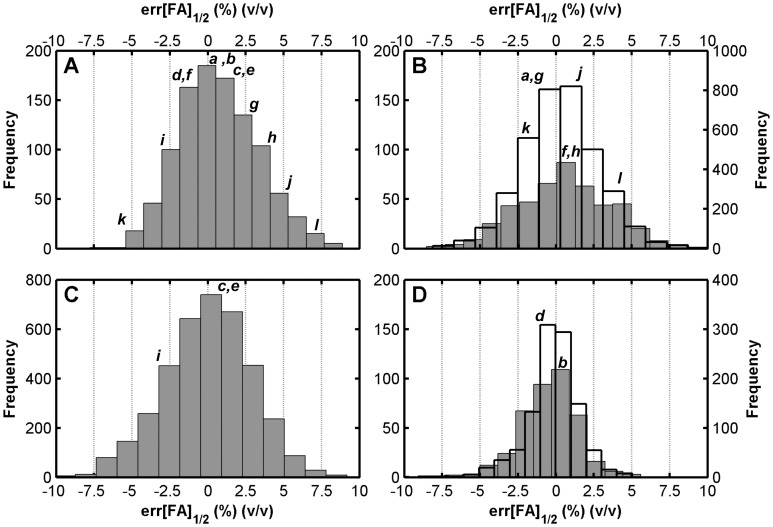
Histograms of prediction errors.(A) Perfect match (Length set), (B) central mismatch (OneM set; open bars, right axis) and bulged mismatch (Gap and Insertion sets; grey bars, left axis), (C) positional mismatch (PosM set), and (D) two-mismatch (TwoM set; open bars, right axis) and tandem-mismatch (Tandem set; grey bar, left axis) probes. Lower case letters indicate bins to which probes in corresponding panels of Figure 2 belong.